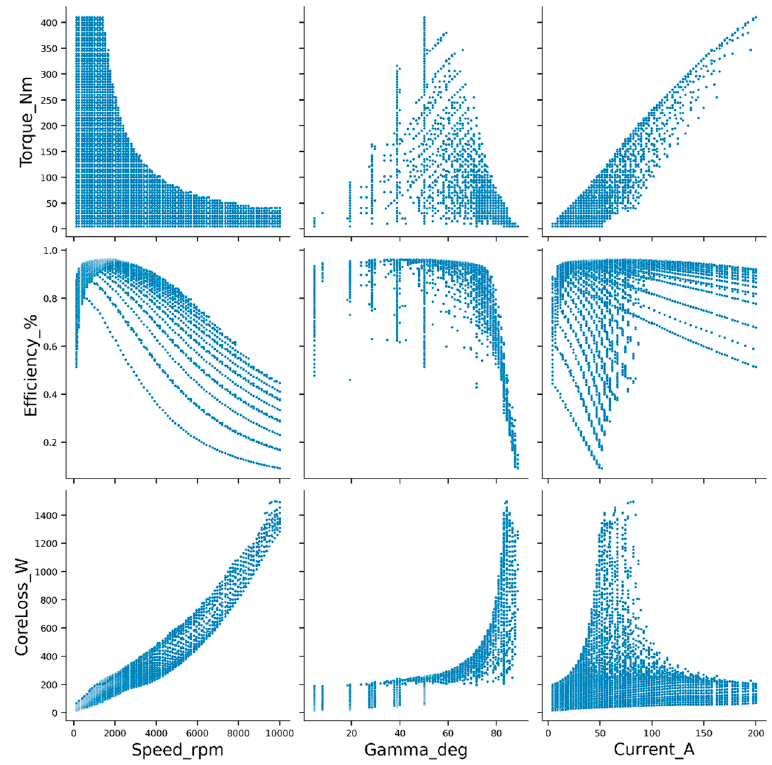
Figure 4. Dataset distribution.